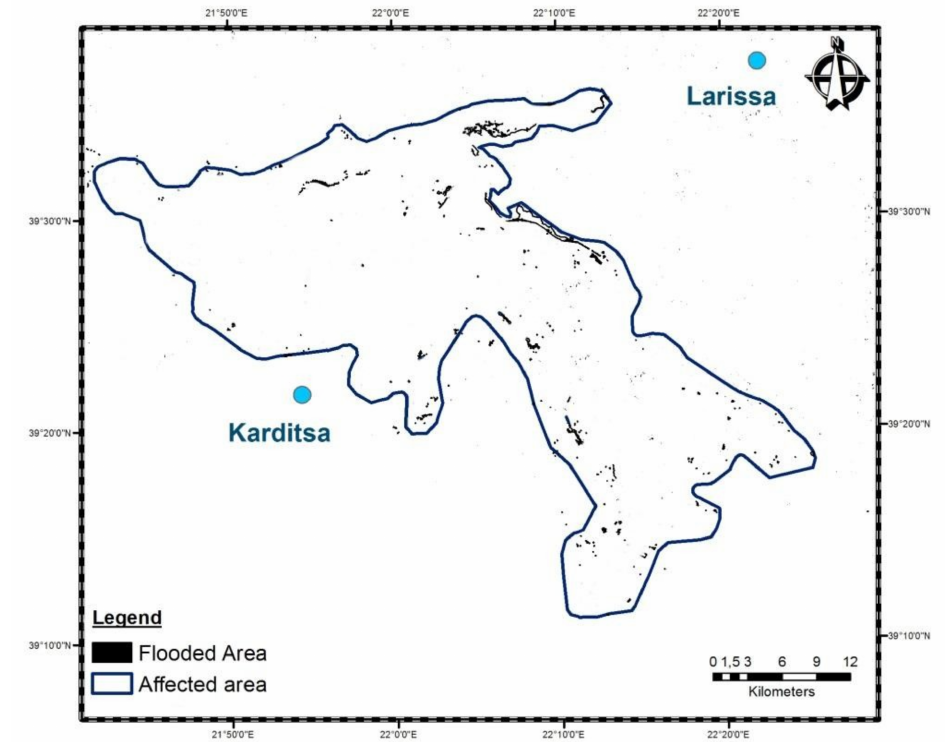
Figure 7. The ‘water’ image derived from the processing of S1 SAR